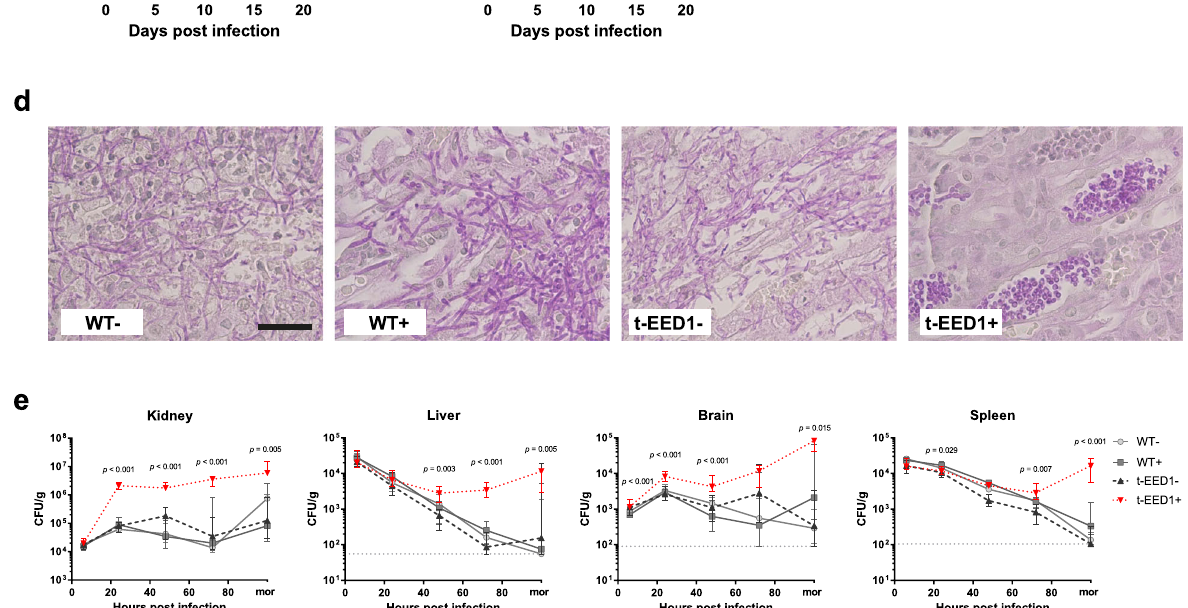
NATURE COMMUNICATIONS| (2021) 12:3899 |https://doi.org/10.1038/s41467-021-24095-8|www.nature.com/naturecommunications